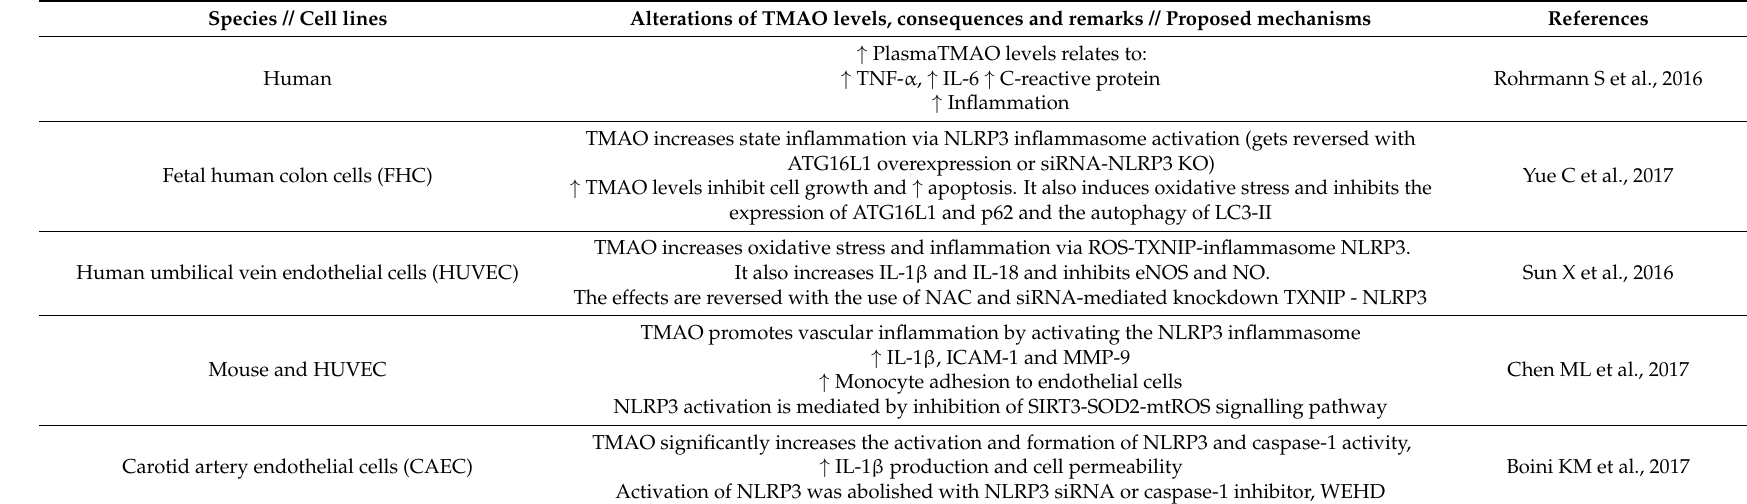
Table 4. Relationships between inflammation and TMAO in different in vivo and cellular